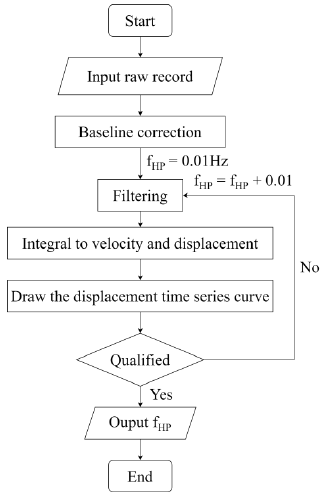
Figure 1. The process of obtaining the high-pass cut-off frequency (f HP is the high-pass cut-off fre-